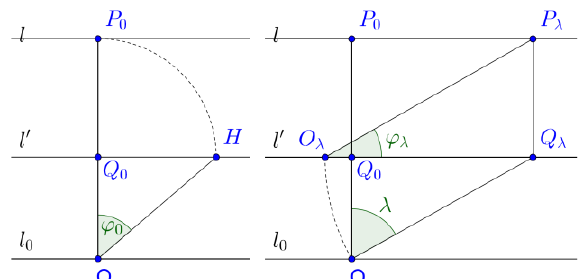
Figure 6 | Left: Setup of orthographic view for calculating φ(λ) of a (0,𝜑 𝜆 ,0) line. Right: Finding the latitude φ(λ) for a given longitude λ.